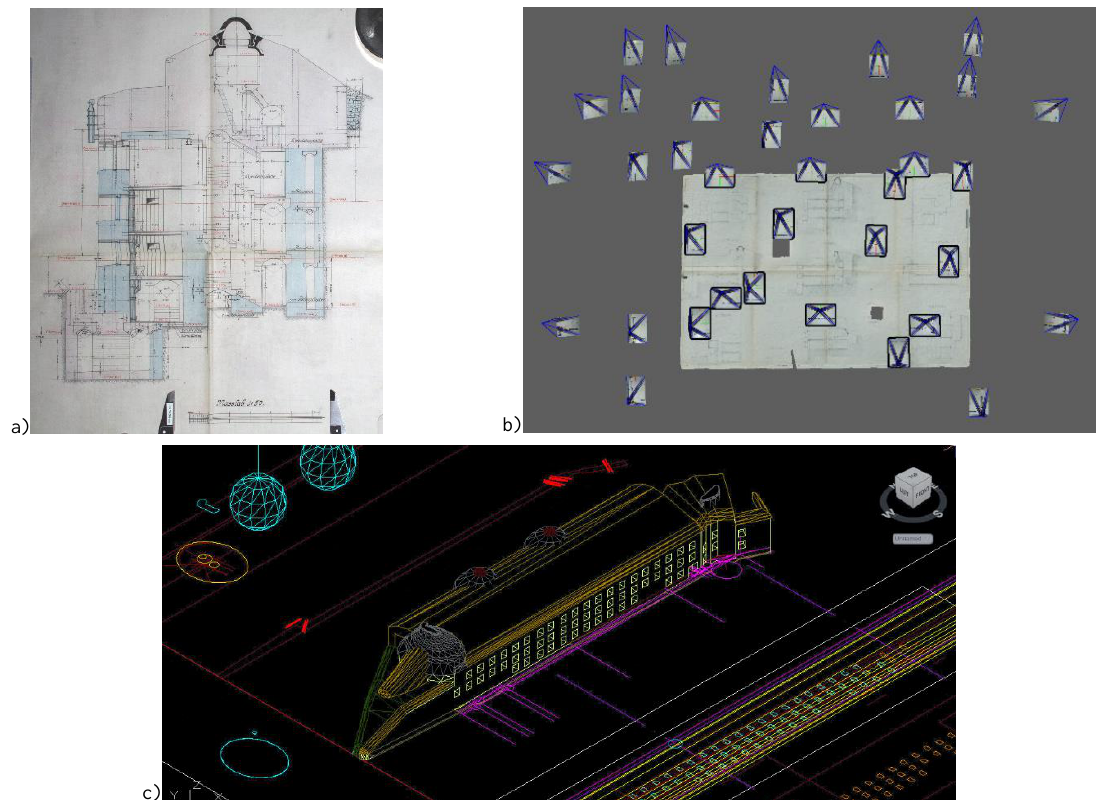
Figure 2. (a) Example of 2D design drawing. (b) Photogrammetric network for the 2D drawing ortho-rectification procedure. (c) Extraction of drawing